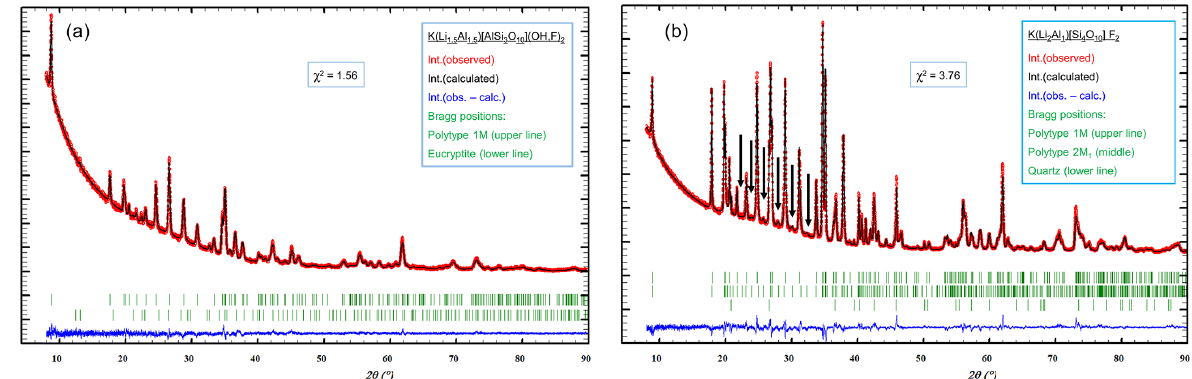
Figure 4. Structure refinement of the sample with nominal composition K(Li 1 . 5 Al 1 . 5 ) [AlSi 3 O 10 ](OH) 1 F 1 (a) and K(Li 2 Al)[Si 4 O 10 ]F 2 (b) . The left diffractogram contains two different phases, 1M and eucryptite. The χ 2 of the refinement is 1.57. The intensity (arb. units) is plotted against 2 θ ( ◦ ) in the range of 8 to 90 ◦ . Three distinguishable phases are present in the right diffractogram: the two polytypes 1M and 2M 1 and quartz as minor phase.